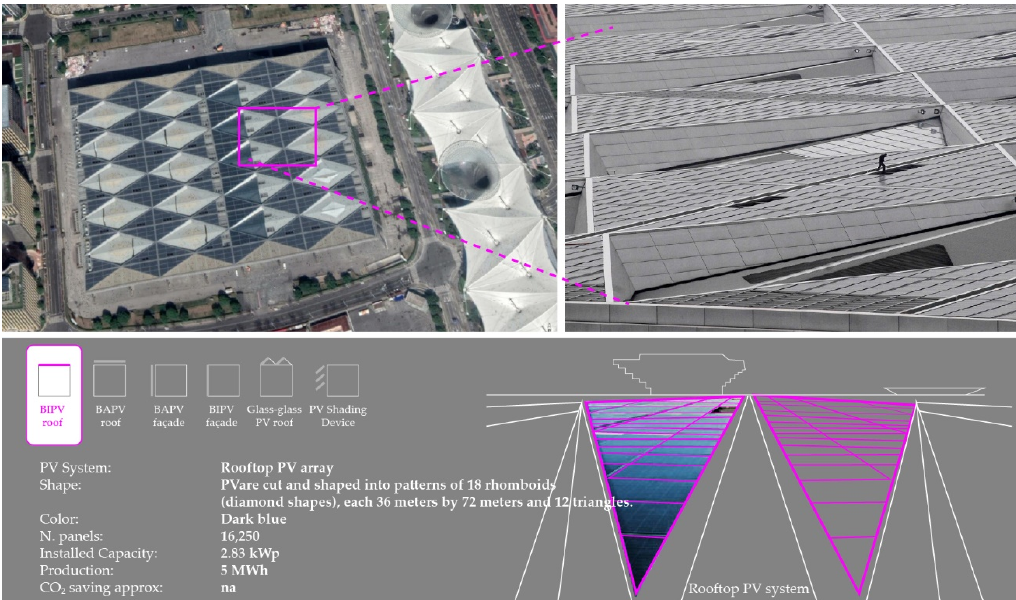
Figure 7. BIPV on the roof of Shanghai Expo 2010 Theme Pavilion, aerial view (source of illustrations: Google Earth, Maxar Technologies, 2020 ( on the top left ); REUTERS_China Daily ( on the top right )); Integration and characteristics of PV systems ( on the bottom ).